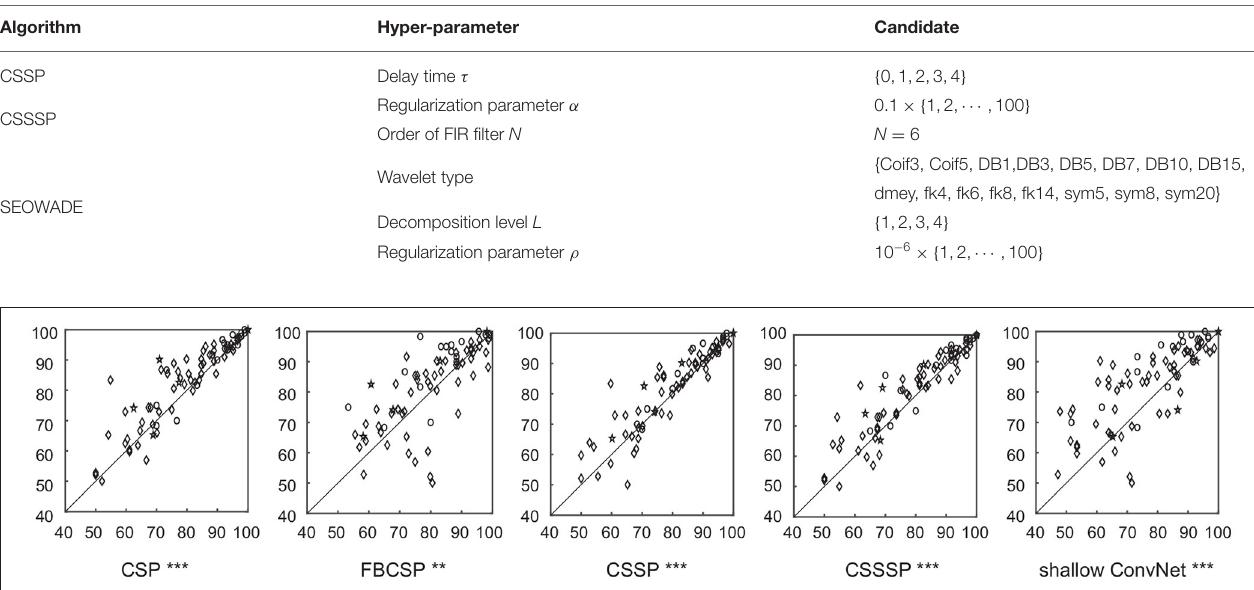
FIGURE 5 | Classification accuracies (%) of the algorithms (CSP, FBCSP, CSSP, CSSSP, and shallow ConvNets) compared with SEOWADE for the 77 binary data subsets, among which the five-pointed stars, circles and diamonds in each sub-figure denote the corresponding data subsets from Data Set A, Data Set B and Data Set C, respectively. Moreover, based on the Bonferronicorrected Wilcoxon signed-rank tests, the significance of the results between the two compared algorithms at the 5, 0.5, and 0.1% levels is indicated by *, **, *** beneath the corresponding sub-figure of this figure.